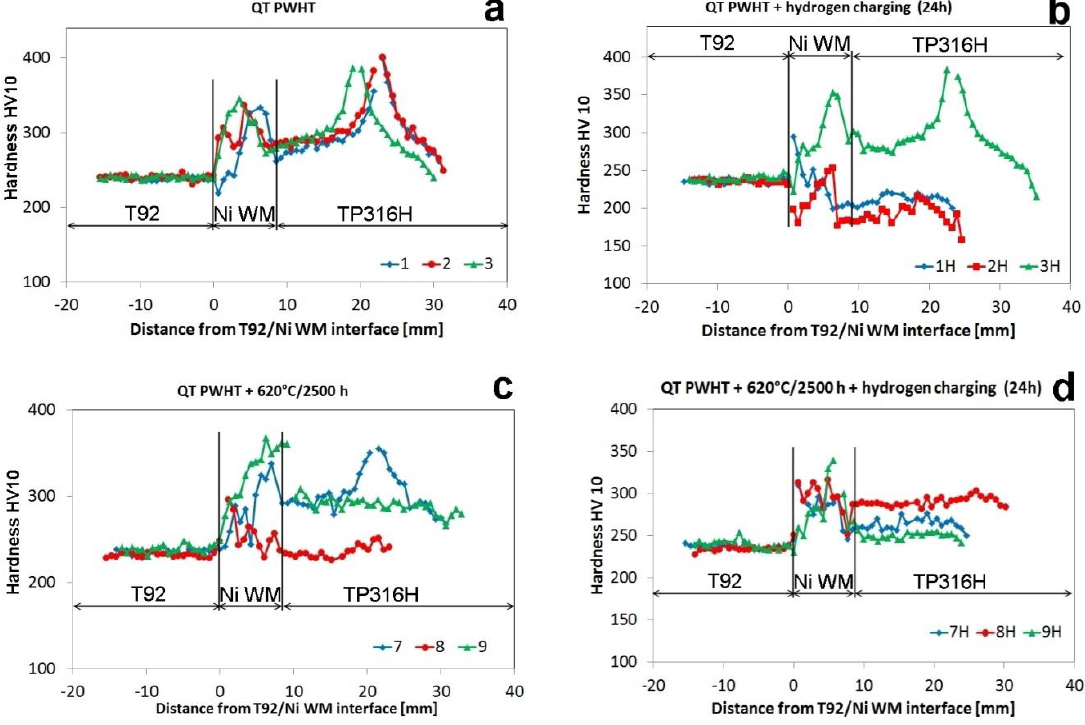
Figure 10. Effects of isothermal aging at 620 °C and electrochemical hydrogen charging at room temperature on the cross-weld hardness profiles determined after room-temperature tensile tests of T92/TP316H dissimilar weldments, states: QT PWHT ( a ); QT PWHT + H ( b ); QT PWHT + 620 °C/2500 h ( c ); QT PWHT + 620 °C/2500 h + H ( d ).